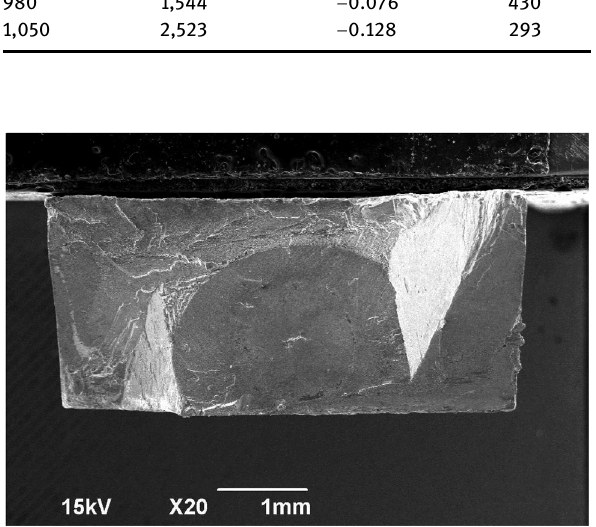
Figure 11: Fracture morphology of specimens without any hole.